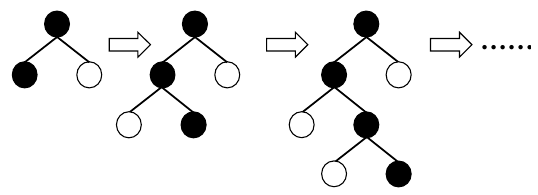
Figure 5. Leaf-wise growth strategy (Black circles represent leaf nodes with branches, and white circles represent leaf nodes without branches).